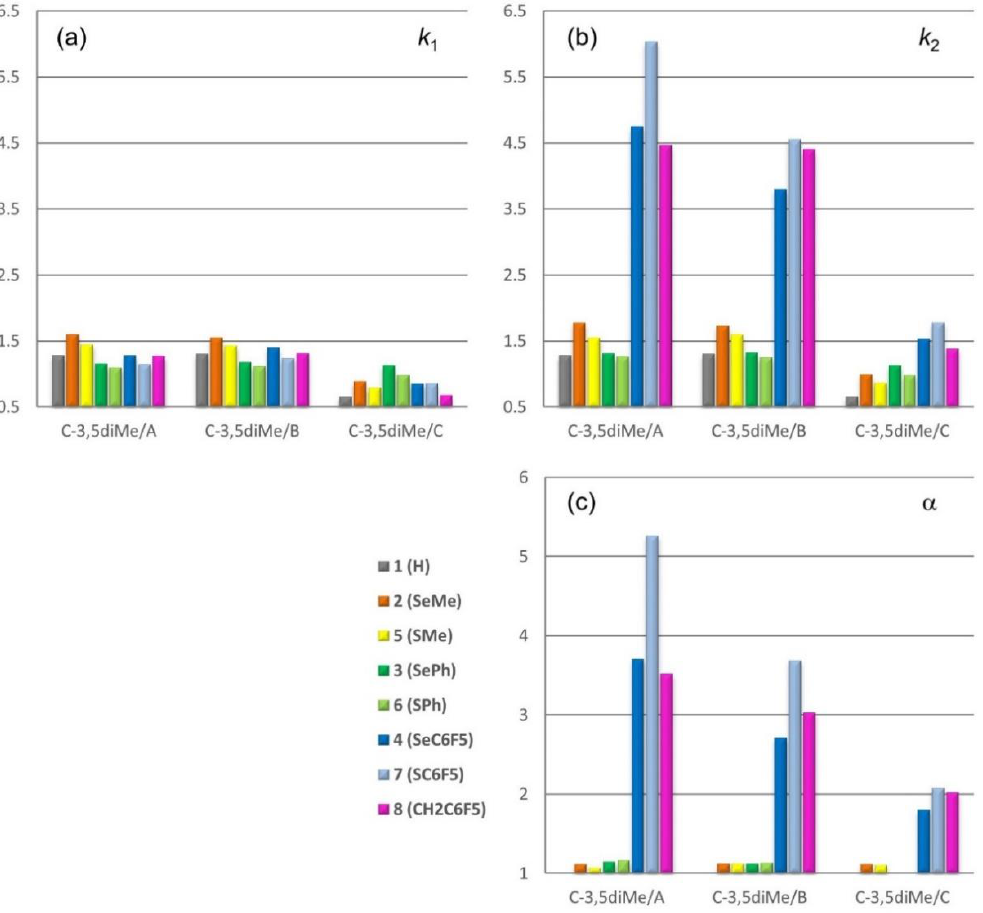
Figure 6. Retention of first ( a ) and second ( b ) eluted enantiomers and selectivity factors ( c ) of the enantioseparations of compounds 2 – 8 on C-3,5diMe with MP = Hex/IPA 90:10 (mix A ), Hex/IPA/MeOH 90:5:5 (mix B), and pure MeOH (mix C). Compound 1 is used as a reference substance.